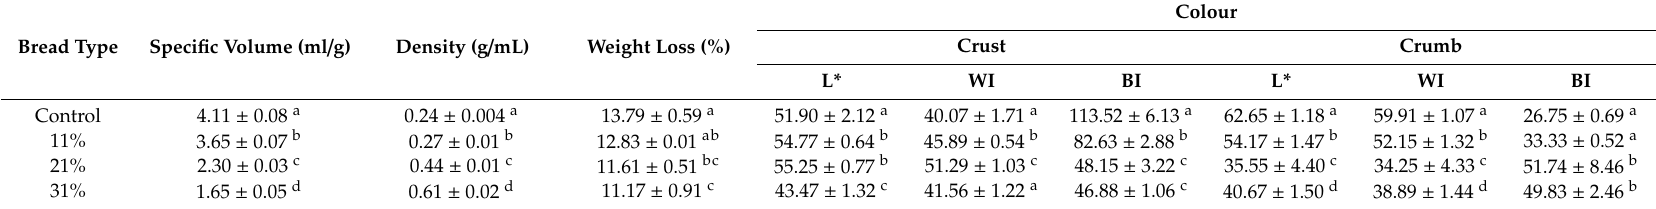
Figure 1. Loaves and slices of bread samples: ( a ) control; ( b ) 11% BBH bread; ( c ) 21% BBH bread; ( d ) 31% BBH bread. Table 2. Physical characteristics of control bread, 11%, 21% and 31% of BBH fortified breads.